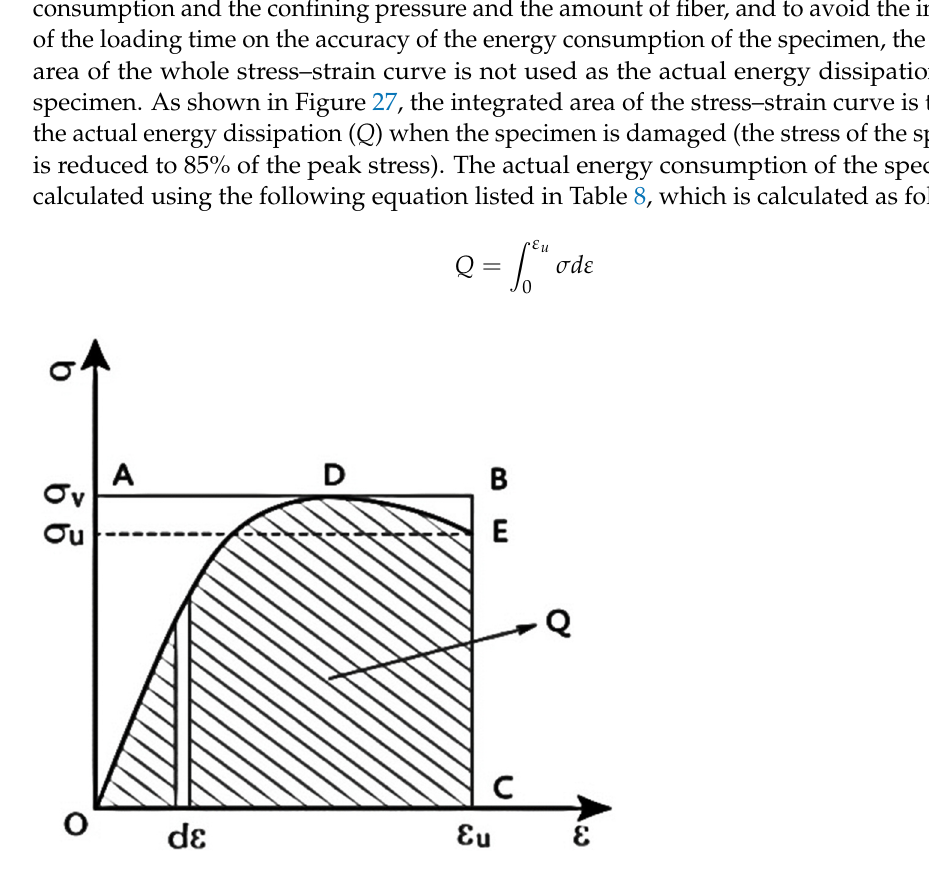
Figure 27. Schematic diagram of energy consumption calculation [29]. Table 8. Actual energy consumption. Table 8. Actual energy